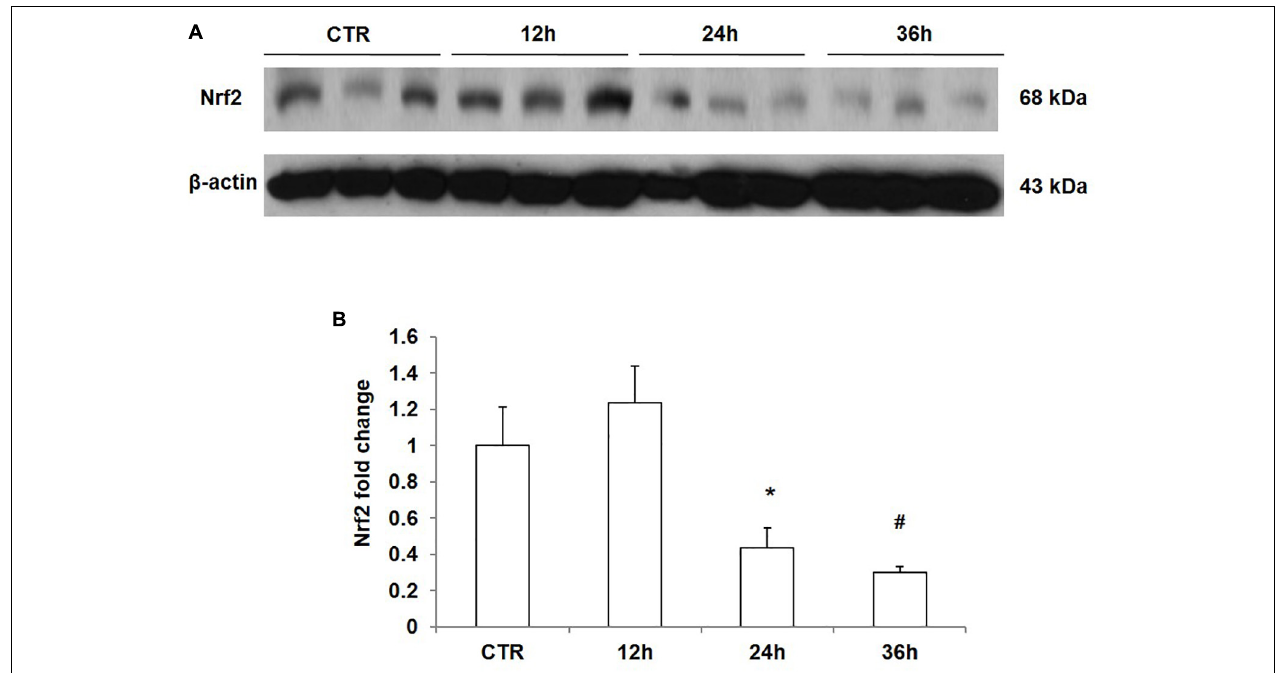
FIGURE 5 | Time course analysis of Nrf2 protein expression in mpkCCD cells after sodium chloride (NaCl) treatment. (A) Western blotting analysis of Nrf2 and β -actin in mpkCCD cells after NaCl treatment for 12, 24, and 36 h. (B) Densitometric analysis of Nrf2 normalized by β -actin in mpkCCD cells after NaCl treatment for 12, 24, and 36 h. The presented data are means ± SE. n = 3 per group. ∗ p < 0.05 vs. CTR (control); # p < 0.01 vs. CTR (control).